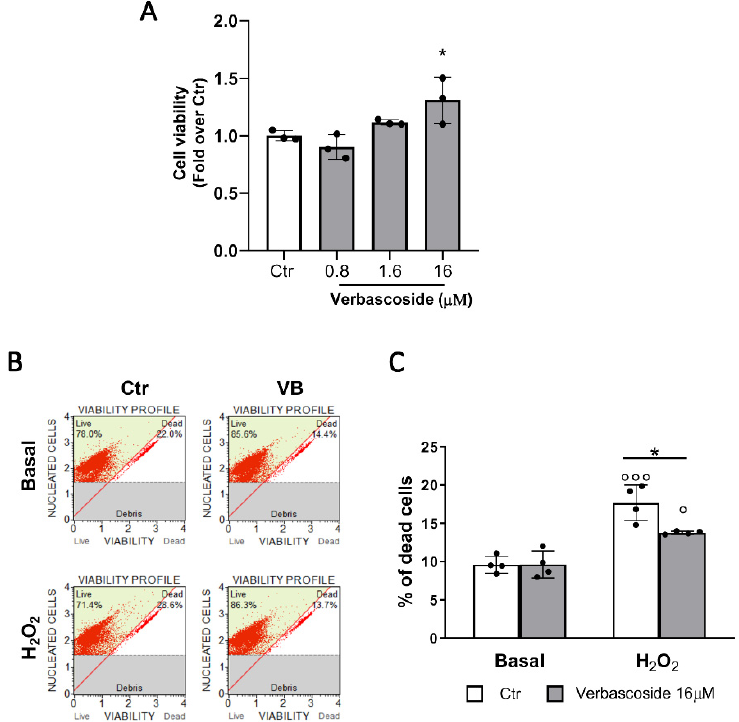
Figure 1. Verbascoside improves β -cell viability. Mouse β tc3 cells were treated with 0.8, 1.6, and 16 µ M verbascoside (VB) for 5 days and methanol treated cells were used as controls. ( A ) MTT test. Data of three independent experiments (mean values ± SD) are expressed as fold change over control. (One-way ANOVA, post-hoc Tukey’s test * p = 0.046 VB vs. Ctr). ( B ) Representative images of flow cytometry experiments. β tc3 cells were trypsinized, labelled with Muse TM count and viability reagent, and analyzed through flow cytometry. Plot organization. Lower panel: cellular debris; upper panel: percentage of live (right part) and dead (left part) cells. ( C ) Quantification of β -cell death by flow cytometry. Data (mean values ± SD) are expressed as percentage of dead cells over total cells; experiments were performed in quadruplicate (two-way ANOVA, post-hoc Tukey’s test. ° p = 0.012, °°° p < 0.0001 H 2 O 2 vs. Basal; * p = 0.018 VB vs. Ctr).